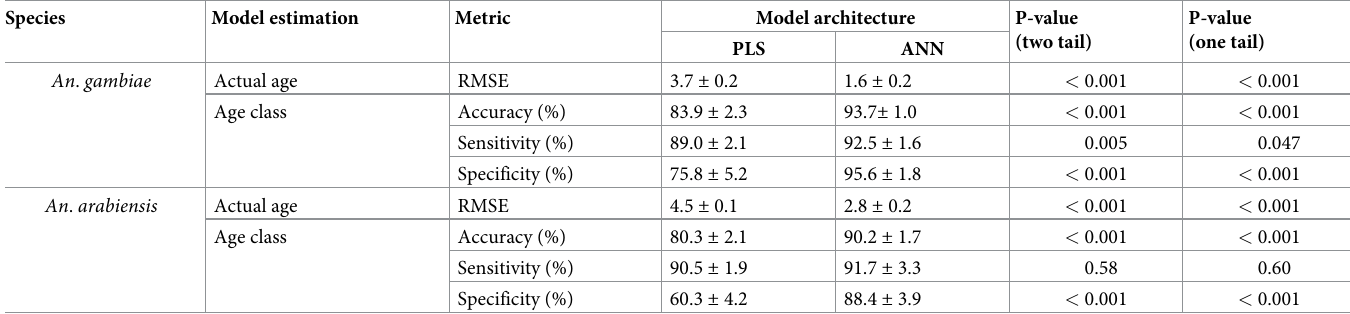
Table 1. Performance analysis of PLS and ANN regression models on estimating the age of An . gambiae and An . arabiensis . Results from ten-fold Monte Carlo cross-validation. Species Model